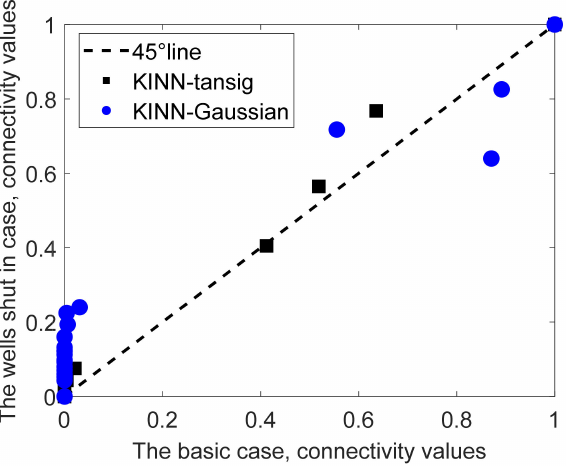
Figure 18. A cross plot of the connectivity values using KINN-tansig and KINN-Gaussian in the wells shut-in case against the basic case results. The black squares and blue circles represent the connectivity values of KINN-tansig and KINN-Gaussian, respectively, and the dashed is 45 ◦